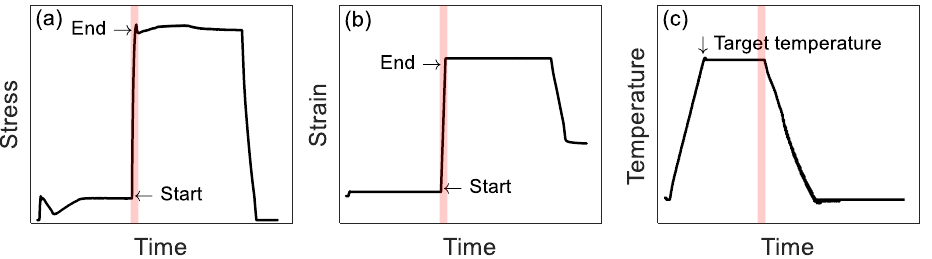
Figure 6. Protocol of the interrupted activation experiment to determine the E SMA ( κ ). ( a ) Stress, ( b ) strain, and ( c ) temperature versus experimental time curves, respectively. Table 1. List of pre-straining and interrupted thermomechanical experiments. The target tempera- tures of interrupted thermomechanical experiments are 50 °C ↑ , 100 °C ↑ , and 160 °C ↑ during heat- ing, and 100 °C ↓ , 50 °C ↓ , and 23 °C ↓ during cooling (‘ ↑ ’ and ‘ ↓ ’ indicate that the thermal cycle was interrupted during heating ‘ ↑ ’ or cooling ‘ ↓ ’).